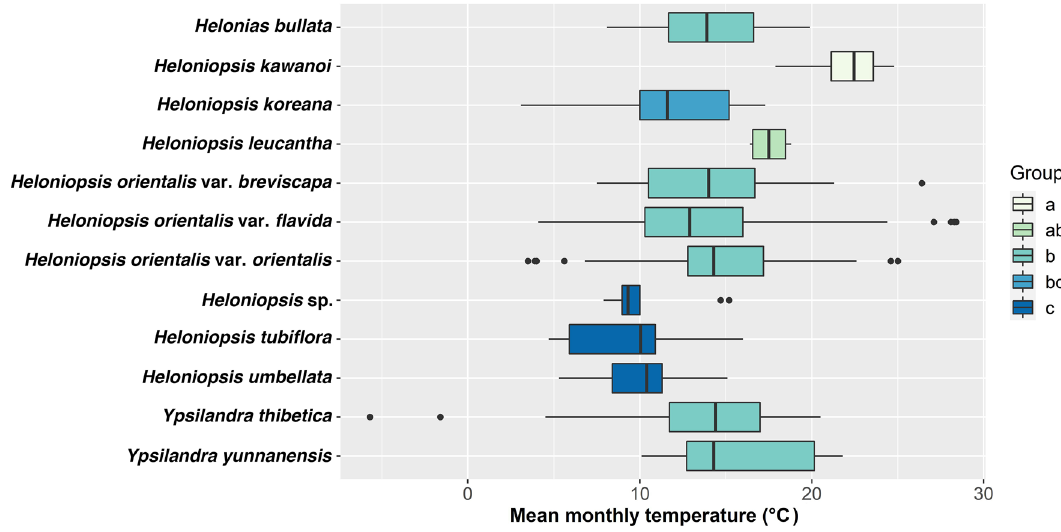
Figure 5. Boxplot of anthesis temperature analysis of Heloniadeae.